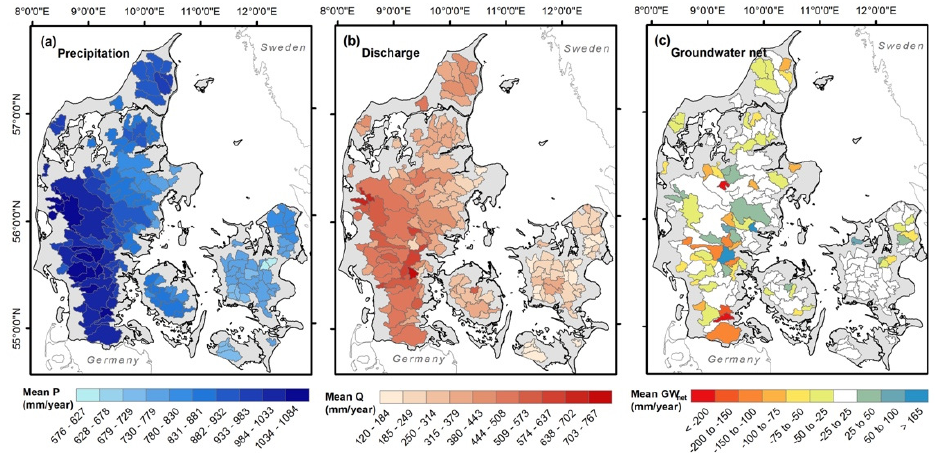
Figure 4. Catchment-based annual mean maps: ( a ) observed precipitation, ( b ) measured surface streamflow, and ( c ) modeled groundwater net (negative values indicate loosing conditions i.e., boundary outflow). All units are in mm/year.